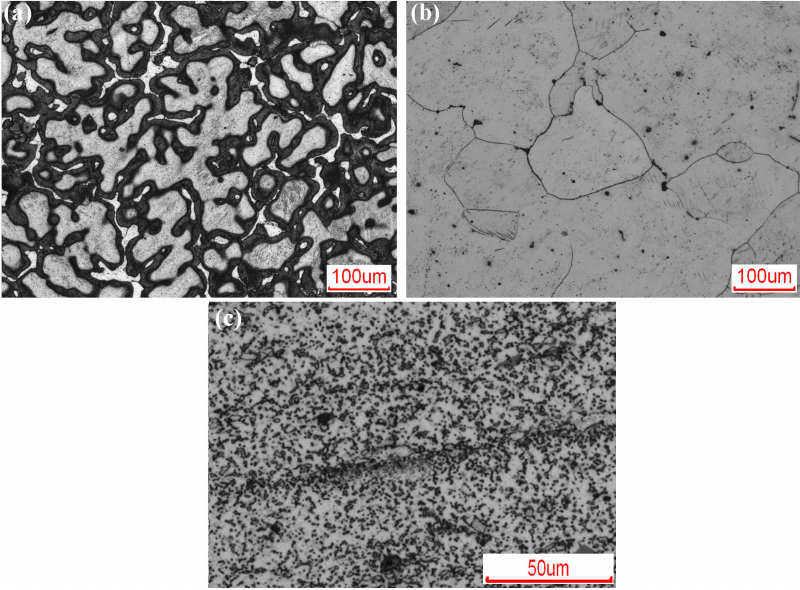
Figure 2. Optical micrographs of the AZ91 alloy: ( a ) as cast, ( b ) solution heat treaded, and ( c ) processed by solution heat treatment and eight passes of ECAP.